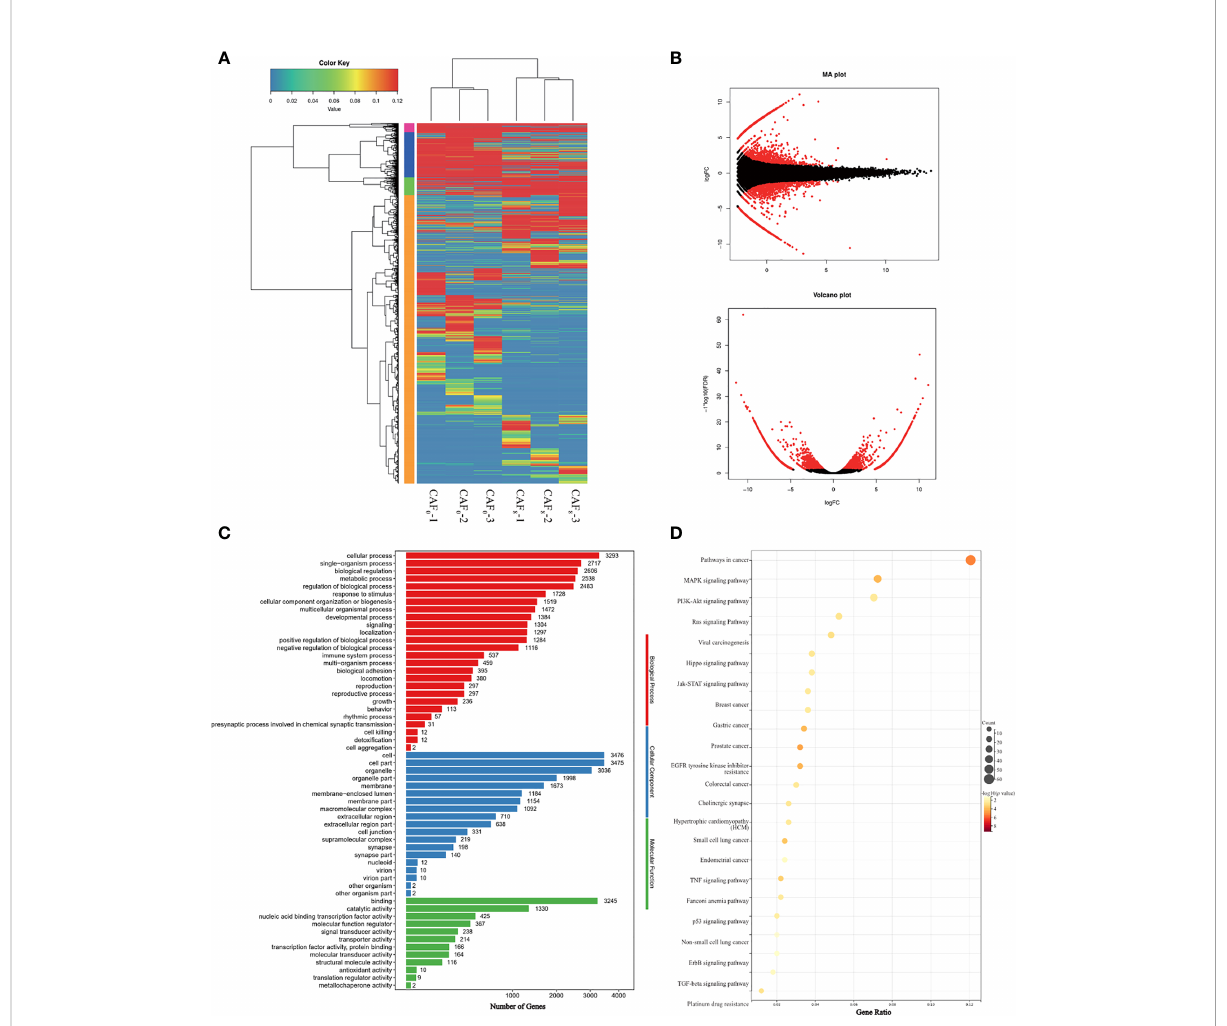
FIGURE 3 Identi fi cation and functional characterization of CAFs under 0Gy and 8Gy irradiation. (A) The cluster analysis of 0Gy compared to 8Gy irradiated CAFs (3 samples for each group) and the heat map showed that the irradiated CAFs differed more signi fi cantly at the gene level; (B) Volcano plot of differential genes after 0Gy vs. 8Gy irradiation of CAFs; (C) Gene Ontology (GO) analysis of differentially expressed genes; (D) Kyoto Encyclopedia of Genes and Genomes (KEGG) analysis of differentially expressed